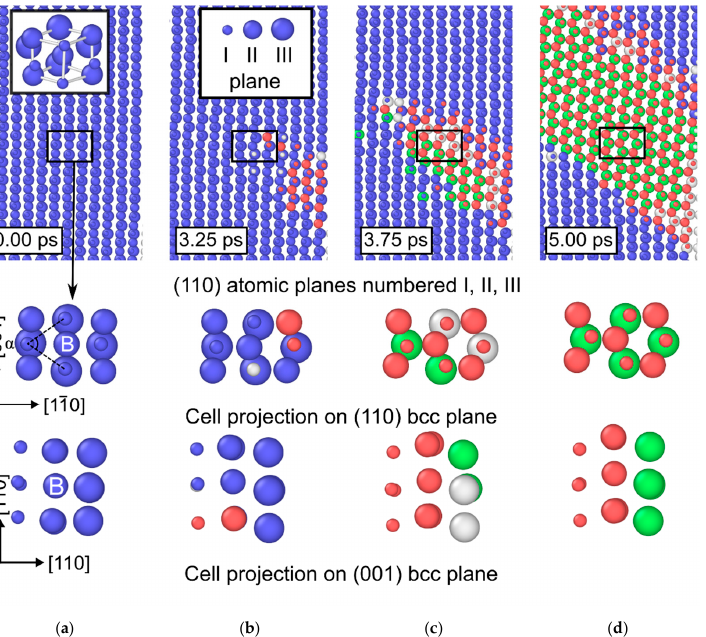
Figure 19. Three adjacent (110) planes (upper row) and projections of the analyzed cell around atom B onto the (110) plane (middle row) and the (001) plane (lower row) at the time instants 0.00 ( a ), 3.25 ( b ), 3.75 ( c ), and 5.00 ps ( d ). The size of atoms corresponds to their position in the bcc (110) planes numbered I, II, and III. Atoms with bcc, fcc, and uncertain nearest neighbor symmetry are shown in blue, green, and gray, respectively. The inset in ( a ) exhibits the initial 3D view of the analyzed atomic cell, where gray solid lines represent the edges of the bcc Bravais cell.